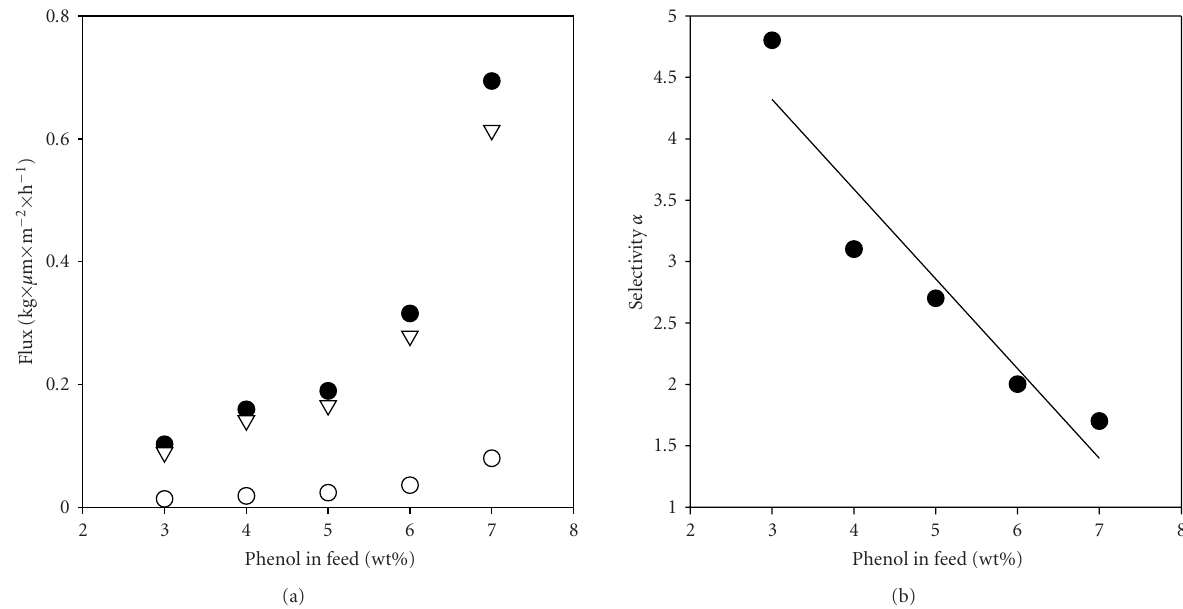
Figure 8: (a) Total flux ( • ), partial water flux ( (cid:2) ), and partial phenol flux ( (cid:4) ) and (b) selectivity with increasing phenol concentration in the feed mixture for the E-MAA 38 at 313 K and a permeate pressure of 15–30 mbar.